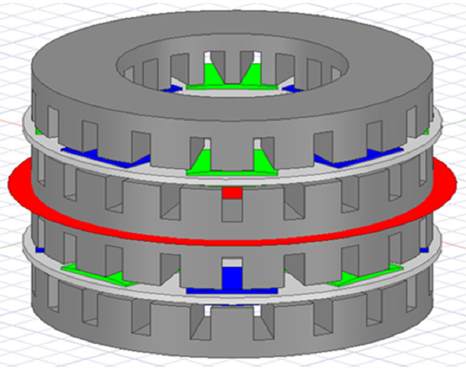
Figure 9. The generator to be optimized by Taguchi method.